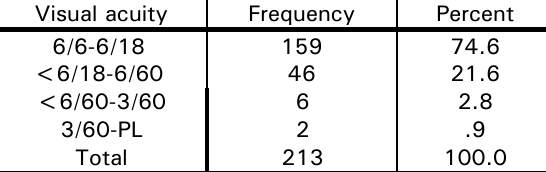
Table 2: Vision in diabetic patients